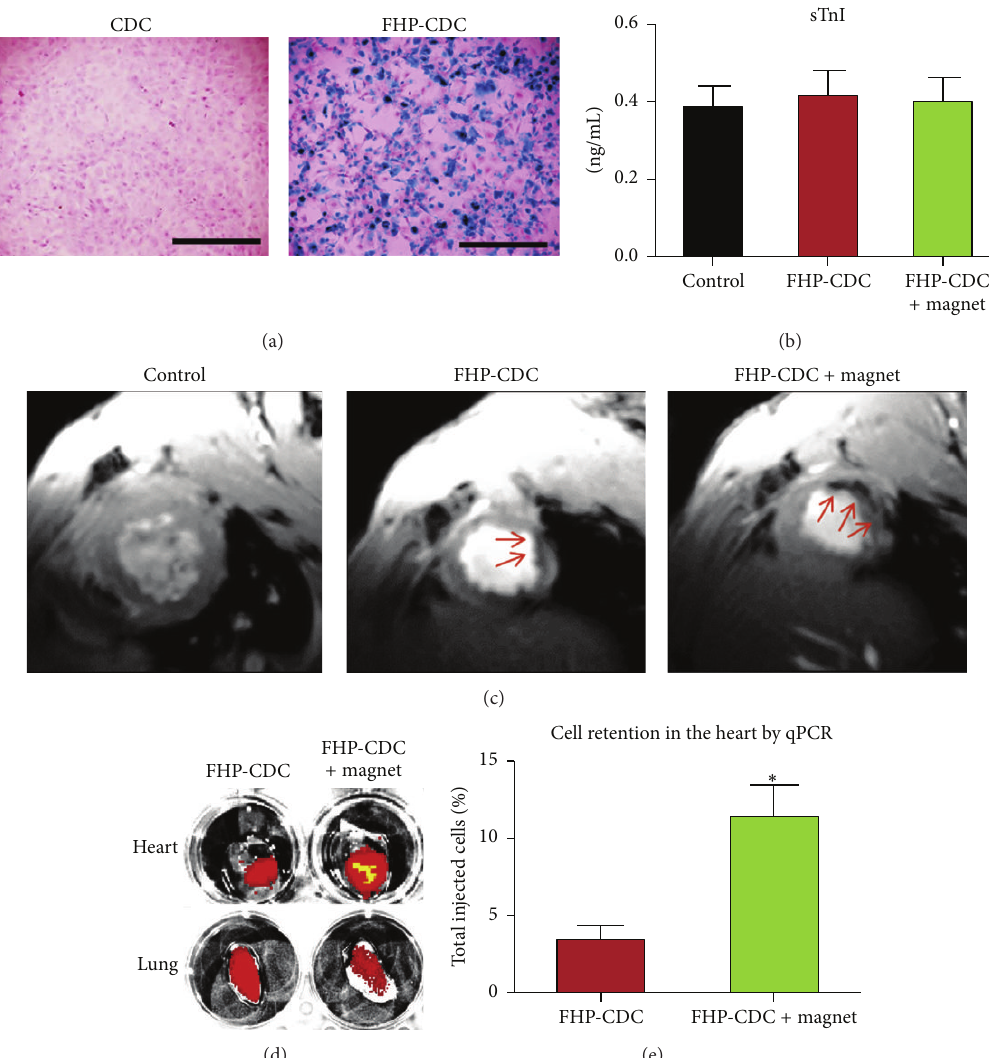
Figure 7: (a) Prussian blue staining showing the proper labeling of rat CDCs with ferumoxytol (FHB), (b) serum cardiac troponin-I (sTnI) values after intracoronary injection of 500,000 cells into noninfarcted rats, (c) T 2 ∗ weighted MRI images showing higher cell retention in magnetic targeted samples (according to their dark signals which are shown by red arrows) 24 h after delivery of CDCs into rats myocardial infarcted model, (d) fluorescent imaging demonstrating the existence of labelled cells (in red, as the cells were transduced by red fluorescent protein) in rat in hearts and lungs, and (e) SRY qPCR quantitation of cell retention (reproduced with permission [44]). ∗ indicates statistical significance with 𝑝 < 0.05